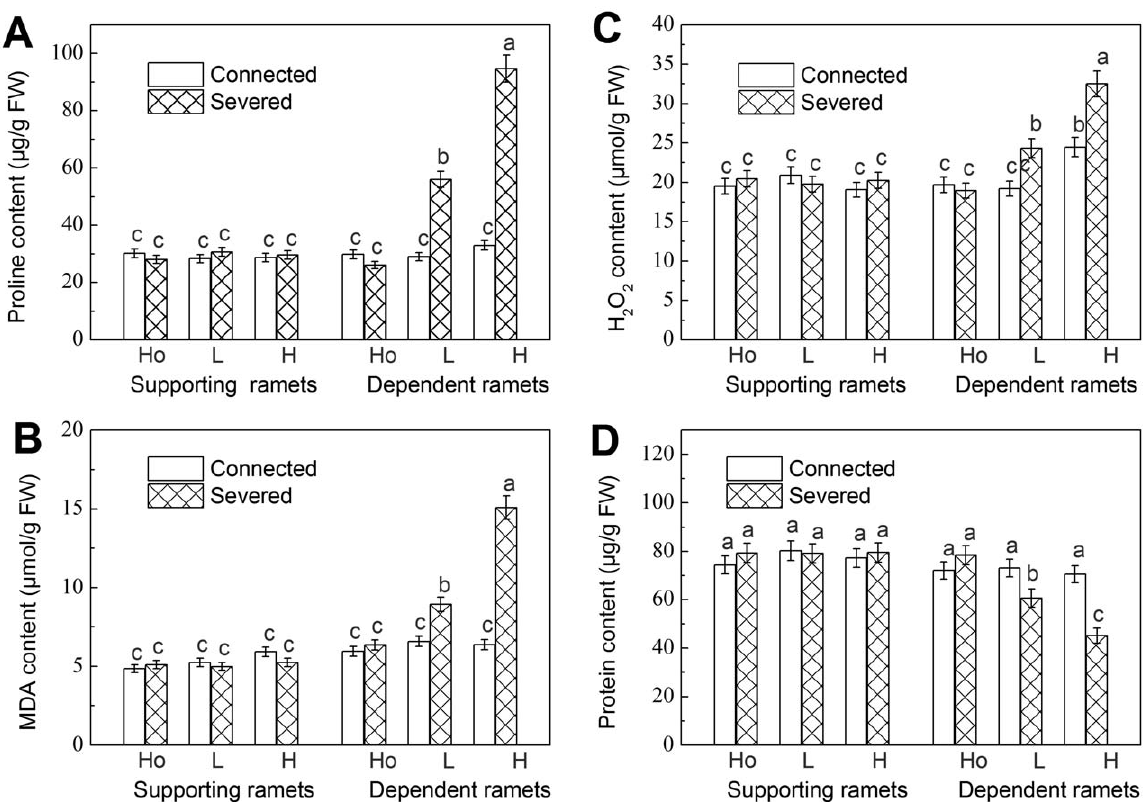
Figure 2. Osmolytes and ROIs. (A) Proline content, (B) MDA content, (C) H 2 O 2 content and (D) protein content of the supporting and the dependent ramets. Data are means 6 SE (n=15). Bars sharing the same lowercase letter are not different at p=0.05. Treatments are coded as in Table 1.